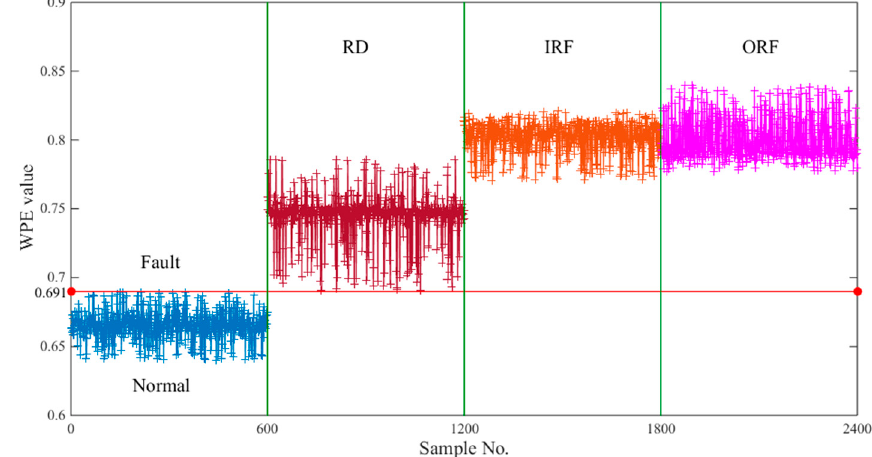
Figure 9. The WPE value of all the samples: the first 600 samples are in normal working condition and their WPE values are lower than 0.691. The rest of the 1800 samples are in defective working condition with roller defect, inner race fault and outer race fault, respectively.